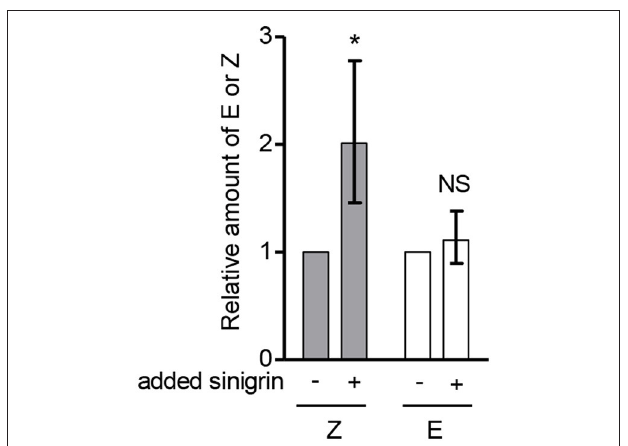
FIGURE 4 | Addition of sinigrin (15) to the myrosinase-containing homogenate of A. petiolata results in formation of the alliarinoside aglucon (12). The relative content of the alliarinoside aglucon (Z) and much lower content of its ( E )-isomer (E) (13) in leaf homogenates following incubation with or without exogenously added sinigrin. Statistical analyses were performed on log 10 -transformed ratios ( n = 3 ). To ease visual interpretation, the back-transformed mean ± standard deviation (SD) is shown. Accordingly, the SD is asymmetric. The one-tailed paired t -test showed a significant increase ( * P < 0.05 ) of the aglucon formed in the presence of exogenously added sinigrin compared to untreated samples. NS, not significant.